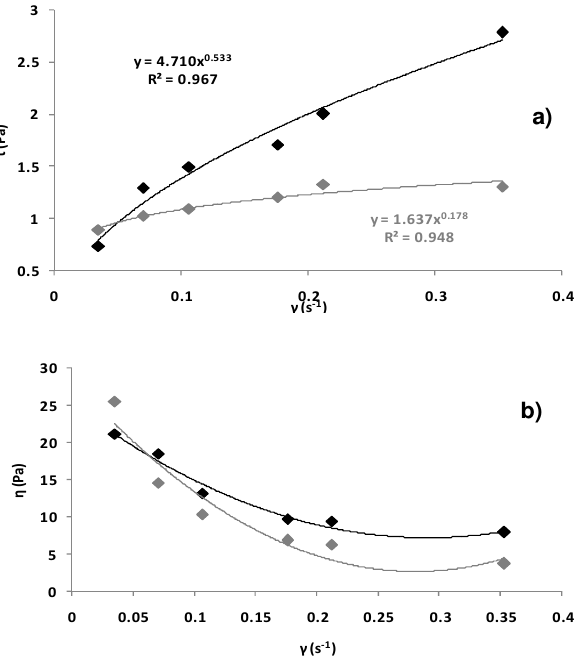
Fig. 5. Variations of the rheological parameters for the fresh pear purée (black) and ohmic treated (grey) pear purée at 25 V/cm; a) Shear stress dependence on shear rate; b) Dynamic viscosity dependence on shear